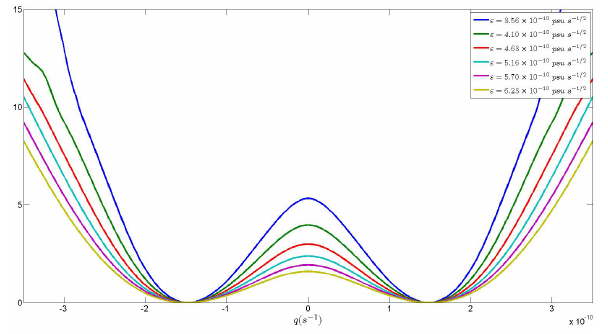
Fig. 3. Goodness of the one-dimensional approach for the reduced 2 d.o.f. model. (a) Average rate of hopping between the north- ern and southern sinking equilibria r( + → − ) = r( − → + ) (black line). The theoretical value is shown with the red line. Data are in units of s − 1 . (b) Geometrical factor G( + → − ) = G( − → + ) of the hopping rate computed from Eq. (7). Adimensional quantity. (c) Value of the parameter γ giving the ratio between ε eff (obtained as a divided by b ) and the theoretically derived expression Adimensional